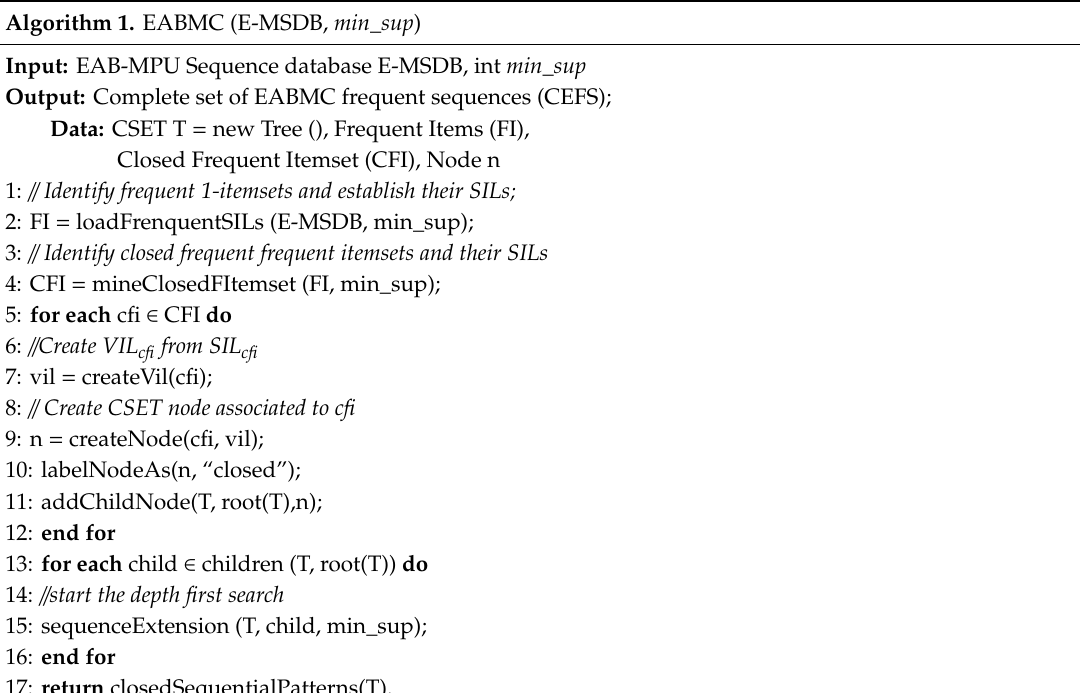
Algorithm 1. EABMC (E-MSDB, min_sup